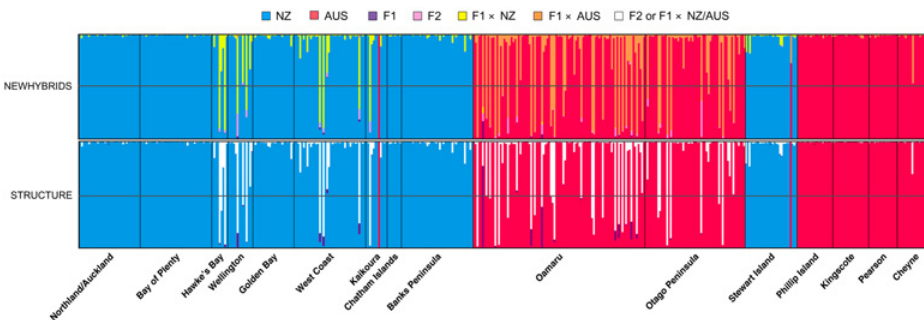
Fig 5. Individual assignment to genetic clusters and hybrid ancestry as determined by STRUCTURE assignment test (bottom plot) and NEWHYBRIDS (top plot). Sampling locations are separated by black vertical lines. Individuals are represented by vertical bars where the colour represents the posterior probability of ancestry of being NZ lineage (blue), AUS lineage (red), a first generation hybrid (F1; purple), a second generation hybrid (F2; pink), a backcross between a F1 and NZ lineage individual (yellow), a backcross between a F1 and AUS lineage individual (orange) or a F2/backcross with either lineage (white; for STRUCTURE plot only). The grey horizontal line indicates 50% posterior probability threshold.